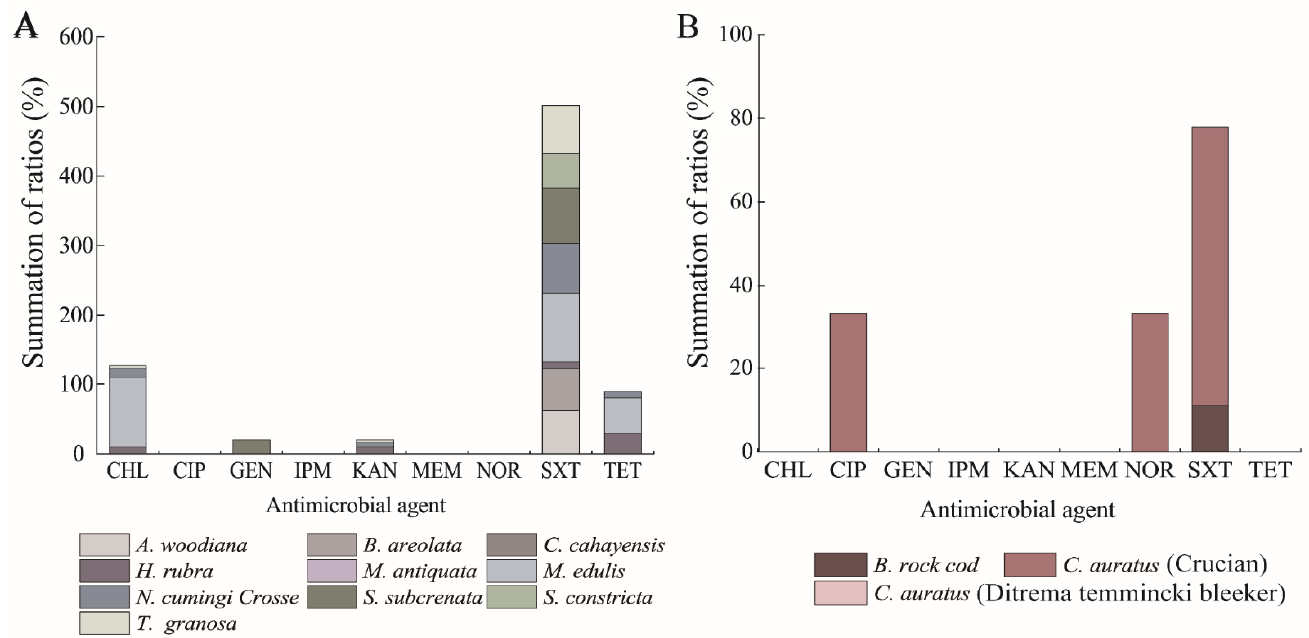
Figure 3. Antibiotic resistance of the 125 K. oxytoca isolates in the 13 species of aquatic animals. ( A ) mollusks; ( B ) fish.